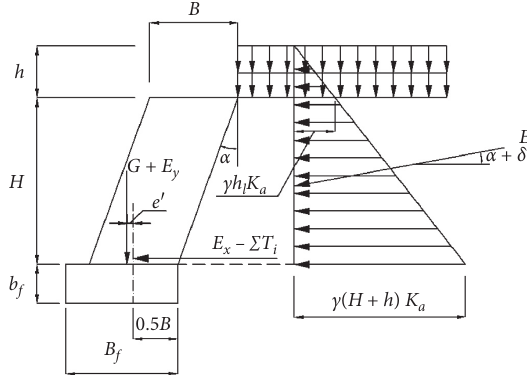
Figure 6: Theoretical calculation of the flexible retaining